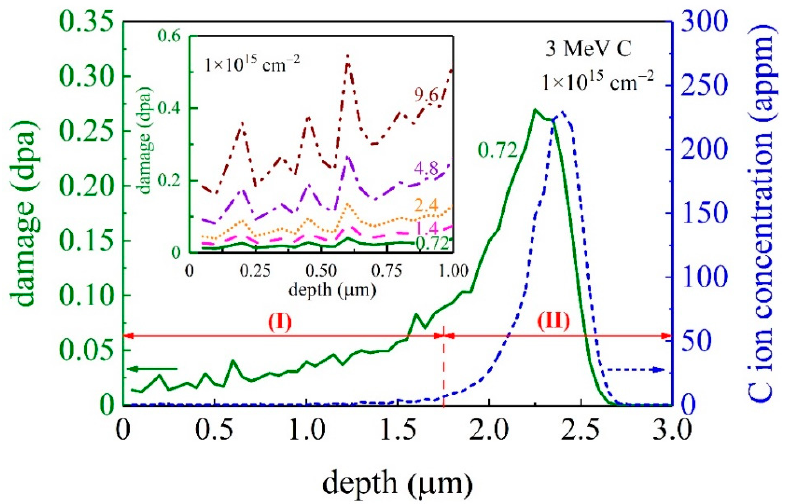
Figure 1. Depth profiles of the displacement damage and C + ion concentration of GaN single crystals implanted with C + at 3 MeV with an ion fluence of 0.72 × 10 15 cm − 2 . Inset is a magnified view of the damage ‐ depth region at all five ion fluences from 0.72 × 10 15 cm − 2 to 9.6 × 10 15 cm − 2 .